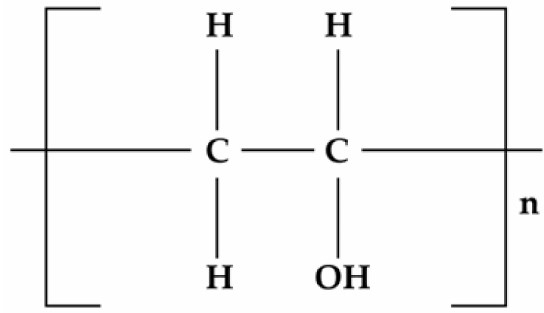
Figure 9. Chemical structure of polyvinyl